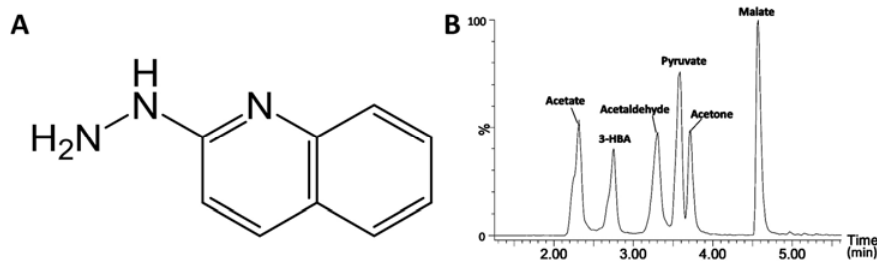
Figure 1. LC-MS analysis of 2-hydrazinoquinoline (HQ) derivatives. ( A ) Structure of HQ; ( B ) a representative chromatogram of HQ derivatives.